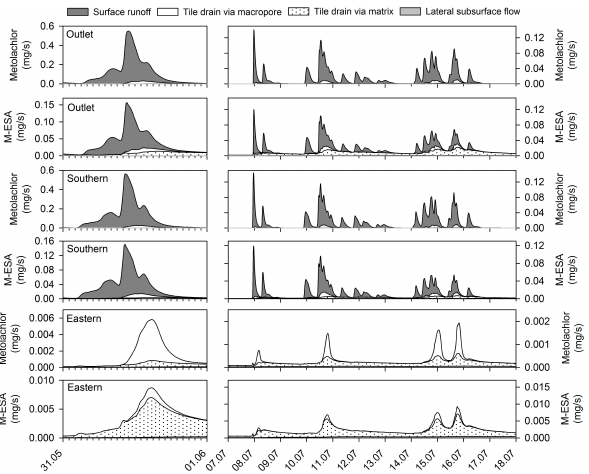
Fig. 6. Modelled pathways of Metolachlor and M-ESA fluxes dur- ing the main export event (23 days after application) and 60–71 days after application at all sampling